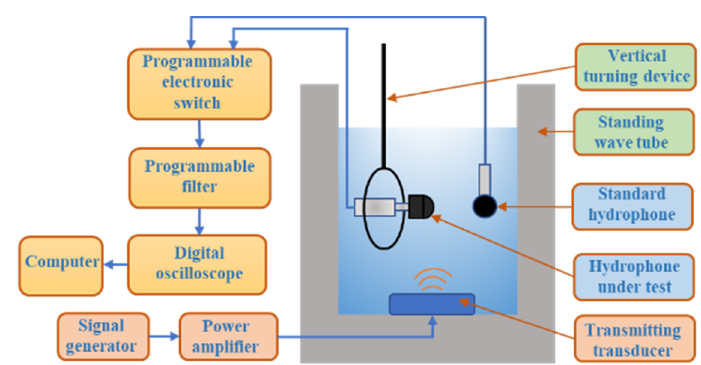
Figure 5. Schematic diagram of hydrophone calibration system.